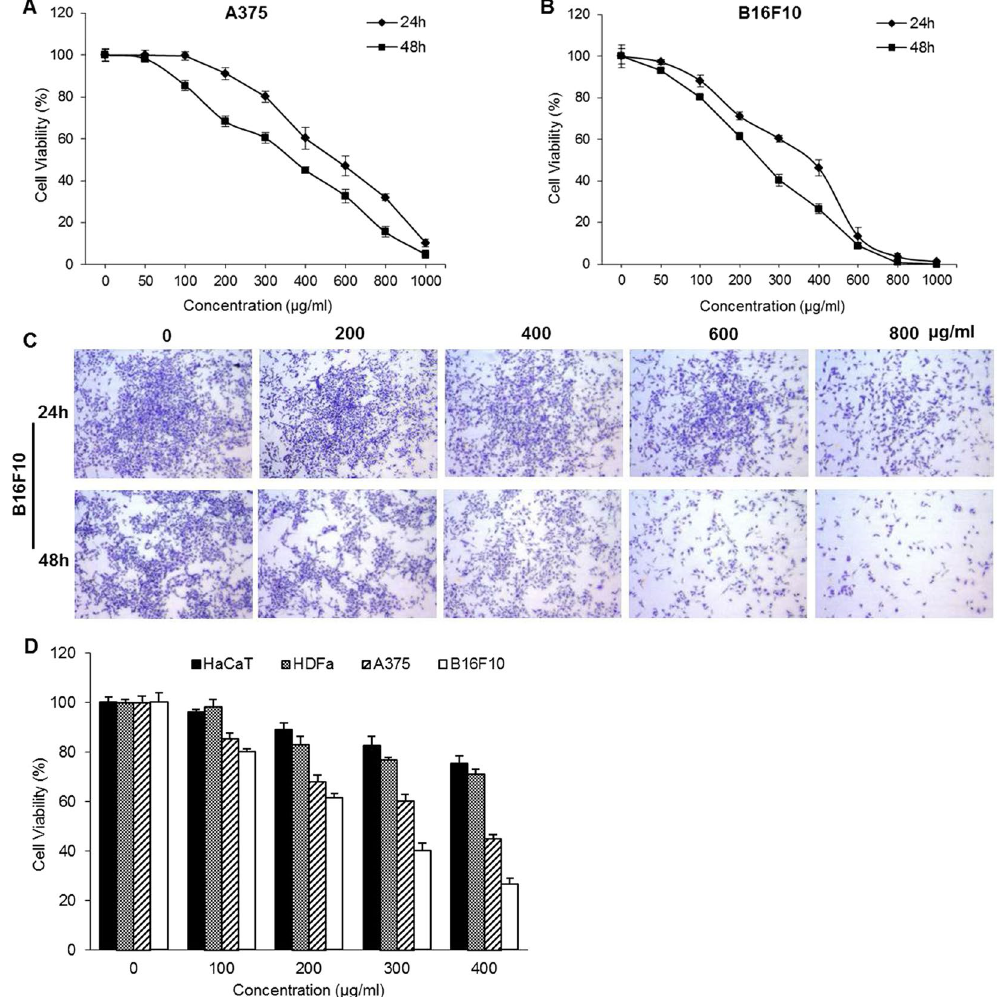
Figure 2. Cytotoxic effects of SLE on melanoma cells and normal skin cells. Effects of SLE on the viabilities of A375 cells ( A ) and B16F10 cells ( B ) were determined by the MTT assay and trypan blue exclusion assay, respectively. ( C ) Proliferation inhibitory effects of SLE on B16F10 cells measured by the crystal violet staining assay. Cells were treated with the indicated concentrations of SLE for 24 or 48 h. ( D ) Comparison of viability inhibitory effects of SLE on melanoma cells and normal skin cells. Cells were treated with the indicated concentrations of SLE for 48 h. Data were presented as means ± SD of three independent